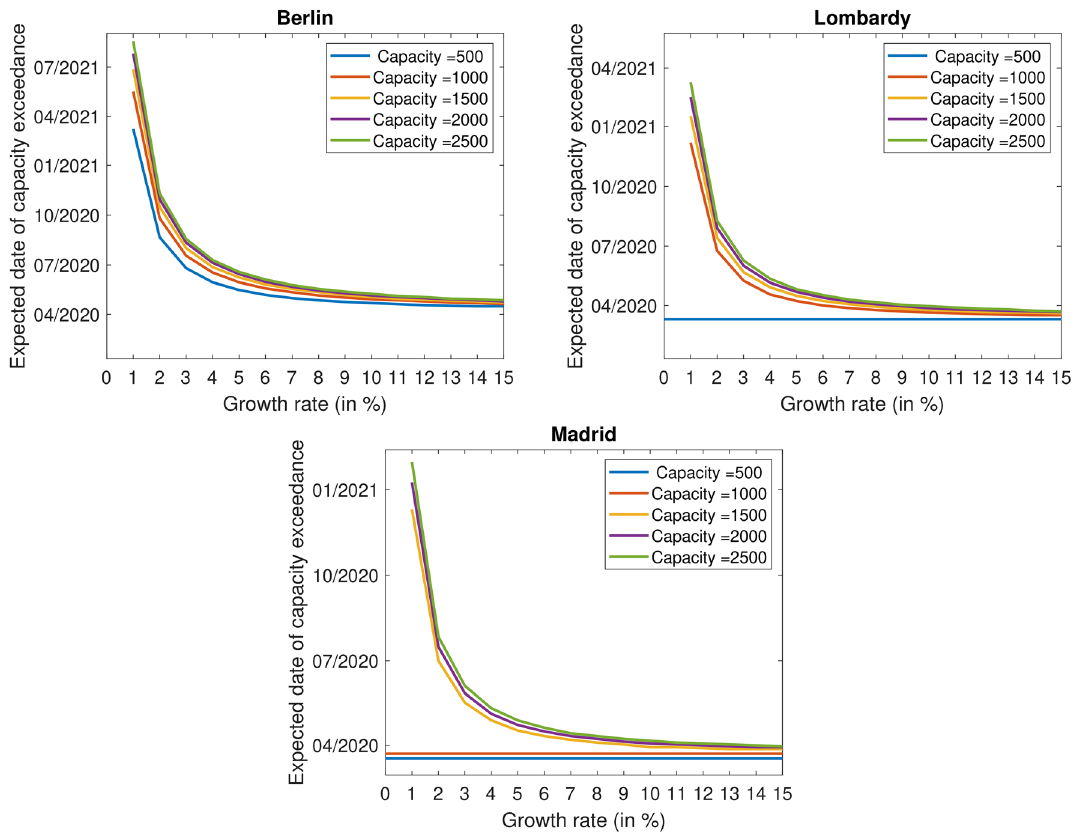
Figure 4. Expected dates of capacity exceedance for different growth rates and exemplary capacities, separately for Berlin, Lombardy, and